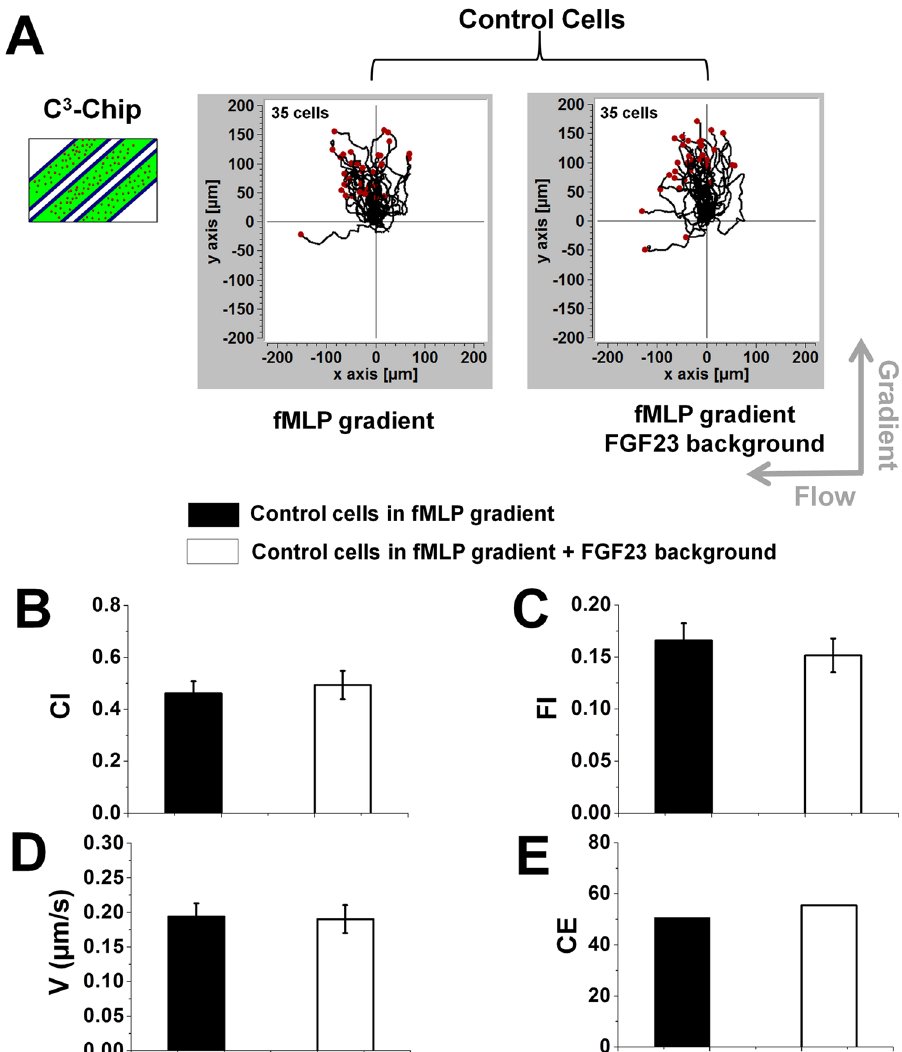
Figure 3. Chemotaxis of un-treated control cells with or without active FGF23 exposure in the C 3 -Chip. Cell migration tracks of control cells in a 100 nM f MLP gradient with (right plot) or without (left plot) a FGF23 uniform background in the C 3 -Chip. The cell tracks are normalized to have the same starting point in the plot. The gradient direction, the flow direction and the number of cells for each plot are indicated; ( B – E ) Comparison of quantitative cell migration parameters including chemotactic index (CI), flowtactic index (FI), speed (V) and chemotactic entropy (CE). The data for each parameter are presented as the average of all cells from representative experiments. The error bar indicates the standard error of the